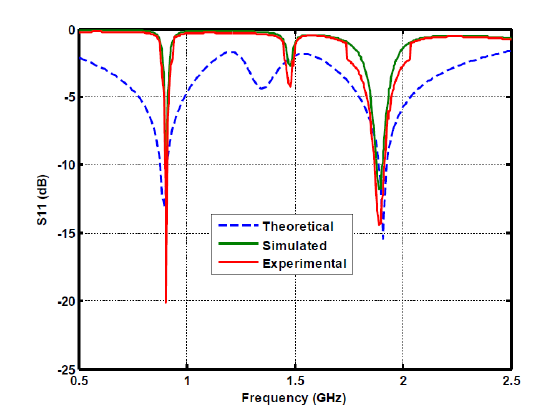
Figure 6: Comparison between theoretical, experimental [25] and simulated [26] results.